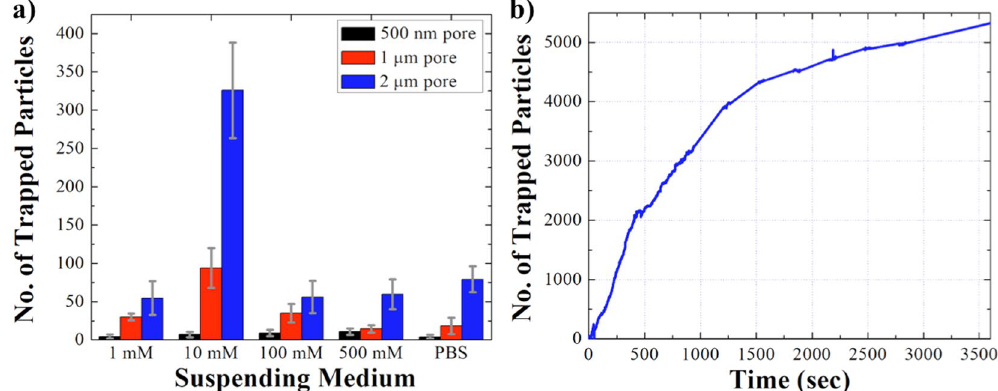
Figure 6. ( a ) The correlation between the number of trapped particles, the ionic strength of the solution, and the pipettes’ diameter. Each experiment was conducted under 10 V/cm with positive bias applied at the base of the pipette and the data was collected after 100 seconds of applied voltage. ( b ) The correlation between the number of trapped particles and the run time. The COOH-PS beads were suspended in 10 mM KCl pH 7.0, and 10 V/cm was applied at the base of the 2 μ m